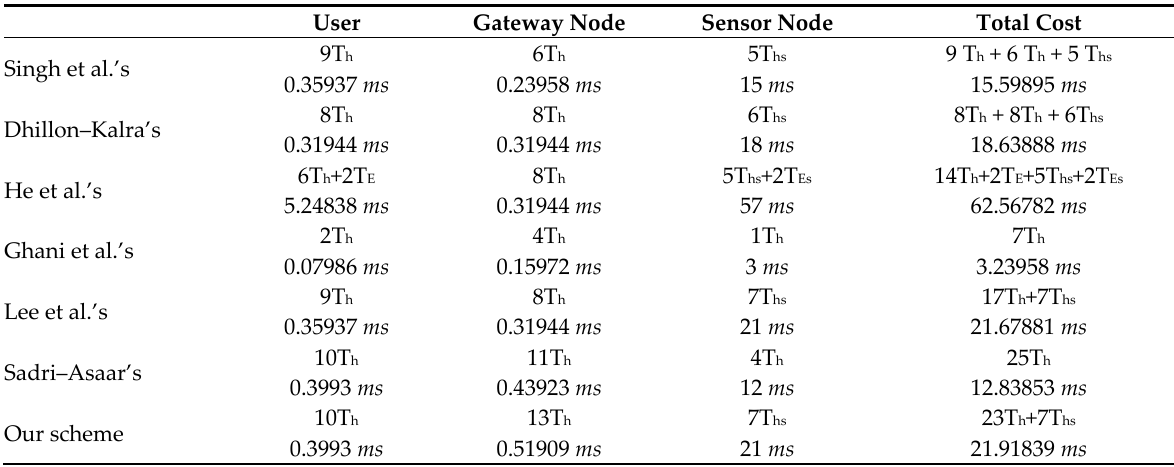
Figure 11. Comparison of computation cost. Table 10. Comparison of computation cost.